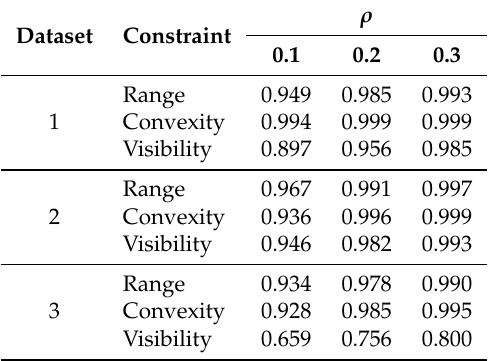
Table 4. Coverage performance with respect to the seed facet